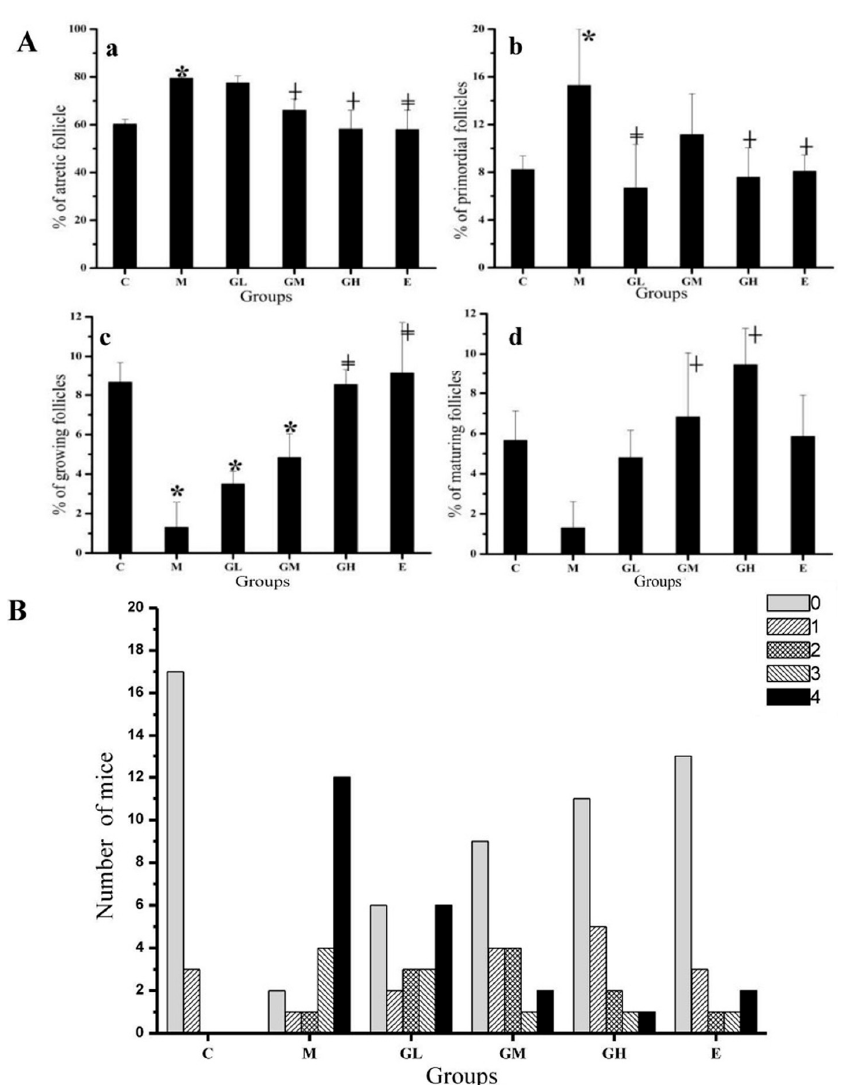
Figure 2. The follicles ratio of every stage and oophoritis morbidity in the ovary. ( A ) The follicles ratio of every stage ( a : atretic follicles; b : primordial follicles; c : growing follicles; d : mature follicles); ( B ) Autoimmune oophoritis was classified according to increasing severity from 1 to 4, 0: normal with no oophoritis. * p < 0.05 compared to control group; † p < 0.05 compared to the model group; ‡ p < 0.01 compared to the model group.